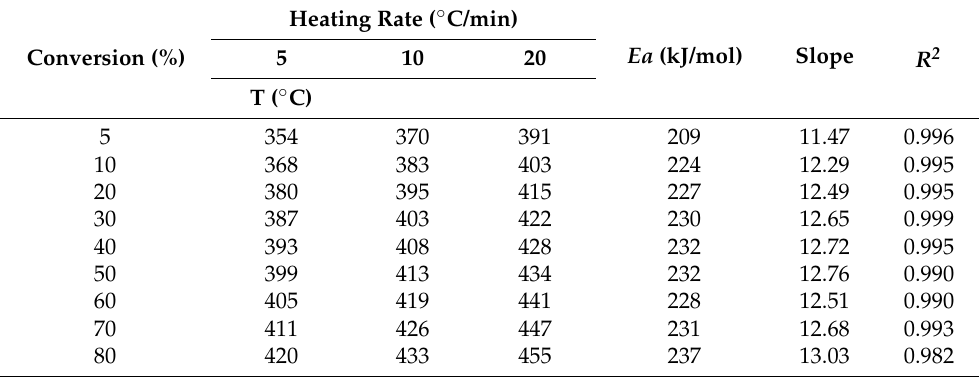
Figure 6. TGA thermal degradation analysis results of the PBT–EVOH polymer composite film using 0.2% triallylamine crosslinking agent. Table 2. The corresponding thermal analysis results of the 0.2%-triallylamine-crosslinking PBT– EVOH polymer composite